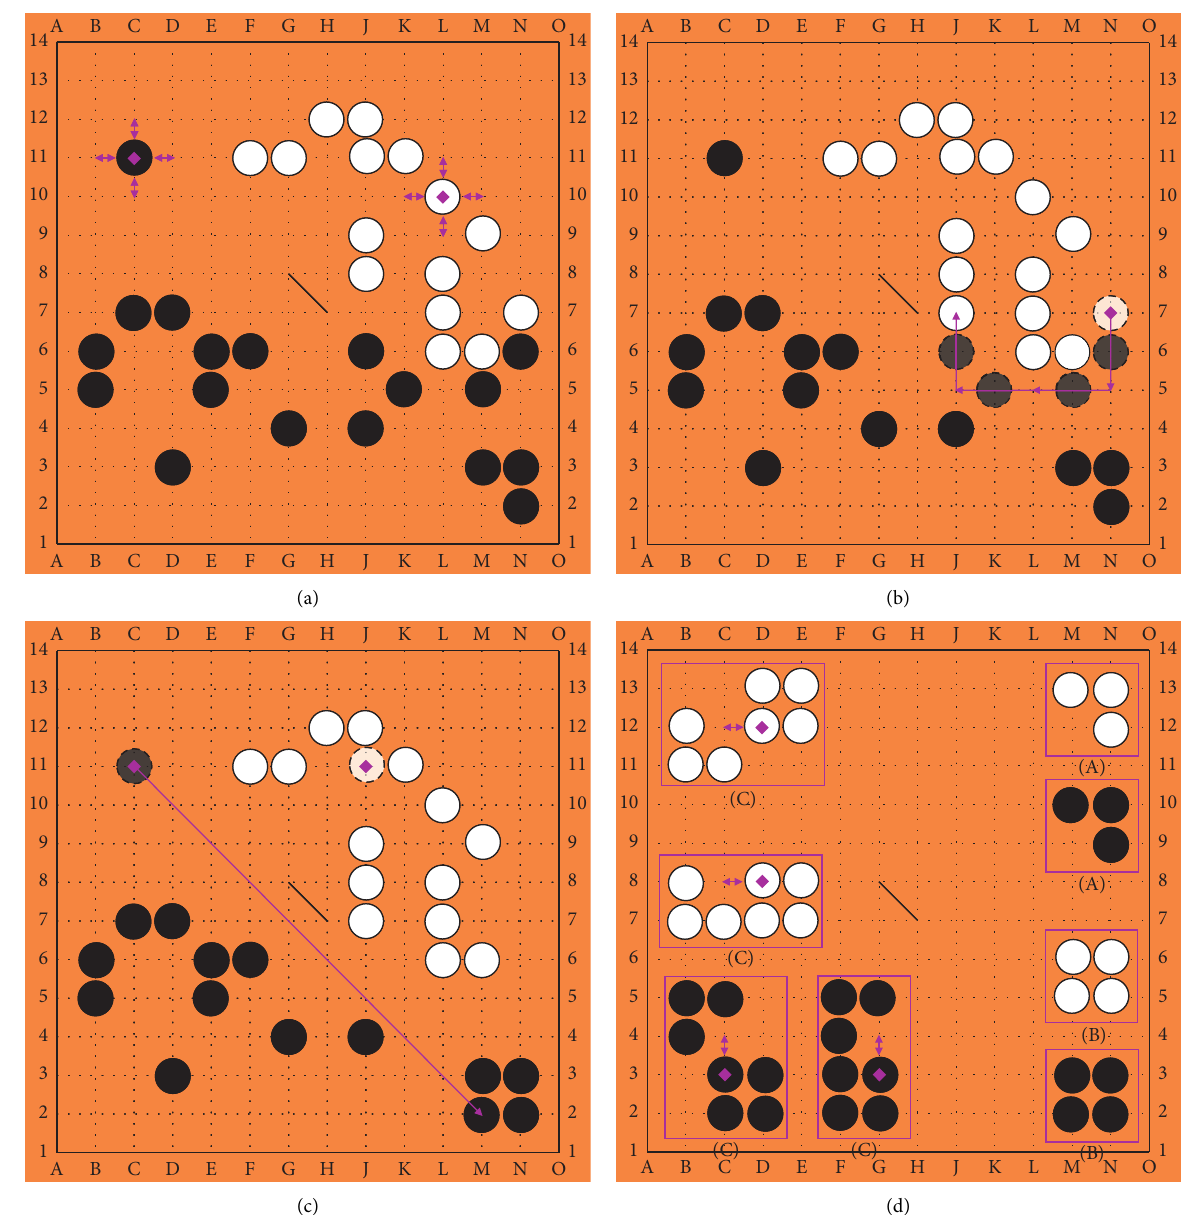
Figure 1: Actions and shapes in Jiu chess. (a) Example state 1. (b) Example state 2. (c) Example state 3. (d) Important